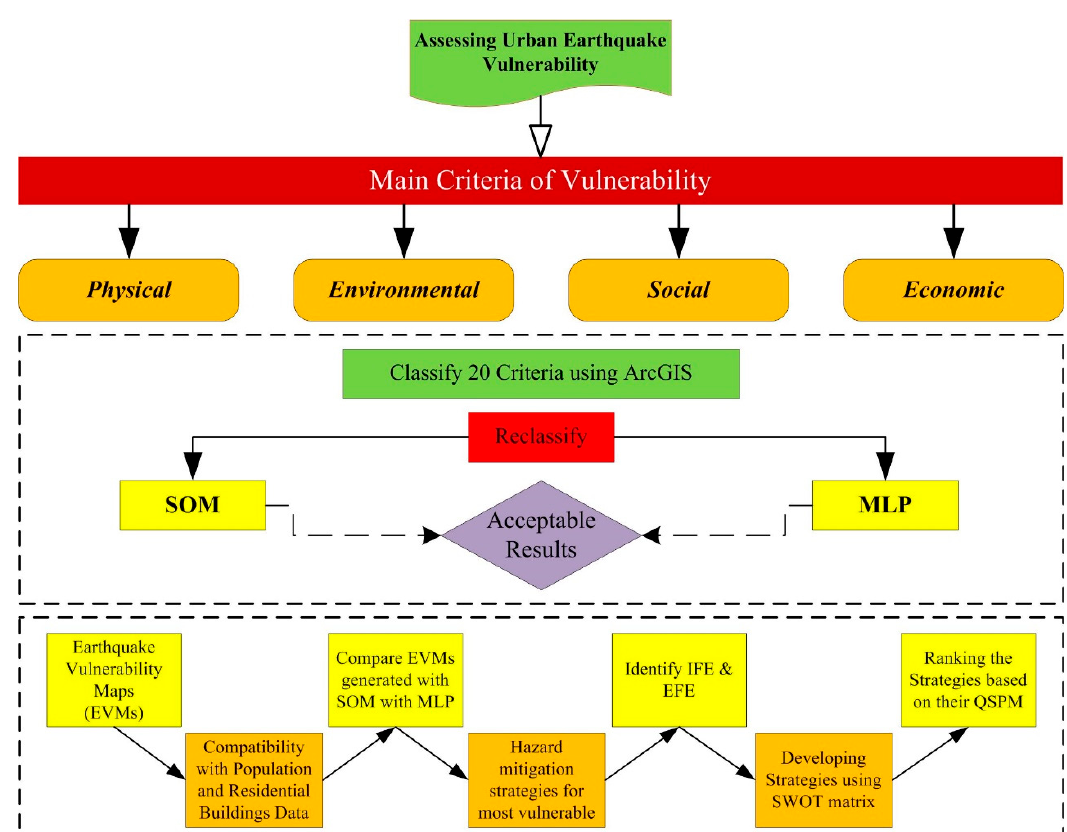
Figure 2. Methodological framework of the study to develop Earthquake Vulnerability Maps.